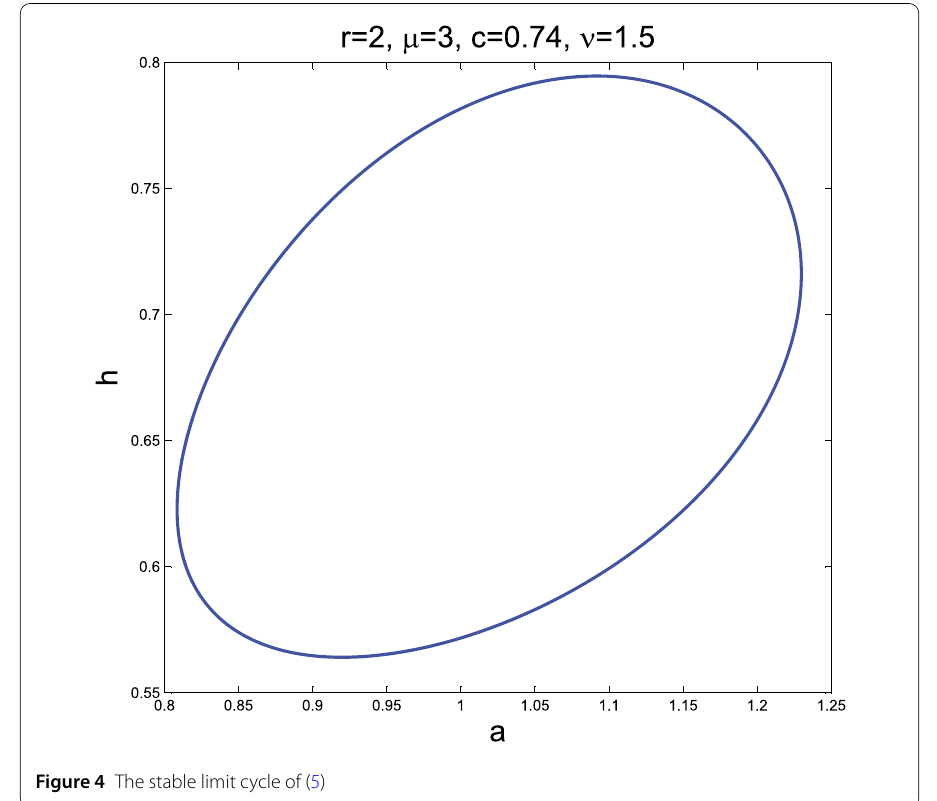
Figure 4 The stable limit cycle of (5)